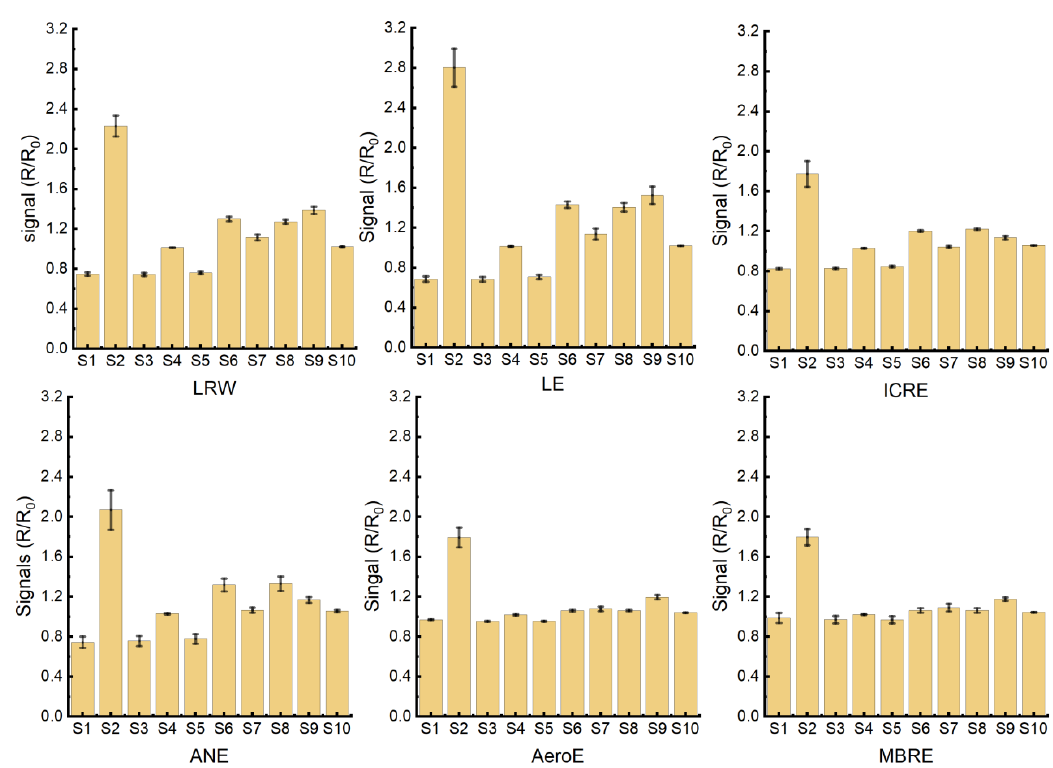
Figure 2. The means and standard deviations of the e-nose sensor signals for each leachate sample. The Pearson correlations between e-nose sensor signals are displayed in Figure 3. The 10 sensors showed different correlations. S1 had high correlations (positive or negative) with S2, S3, S5, S6, and S8. S1 had high correlations with S1, S2, S3, S5, S6, S7, S8, and S9. These correlations were observed frequently among the e-nose sensors, suggesting that the headspace gas information could be detected by all sensors but may have overlapped.